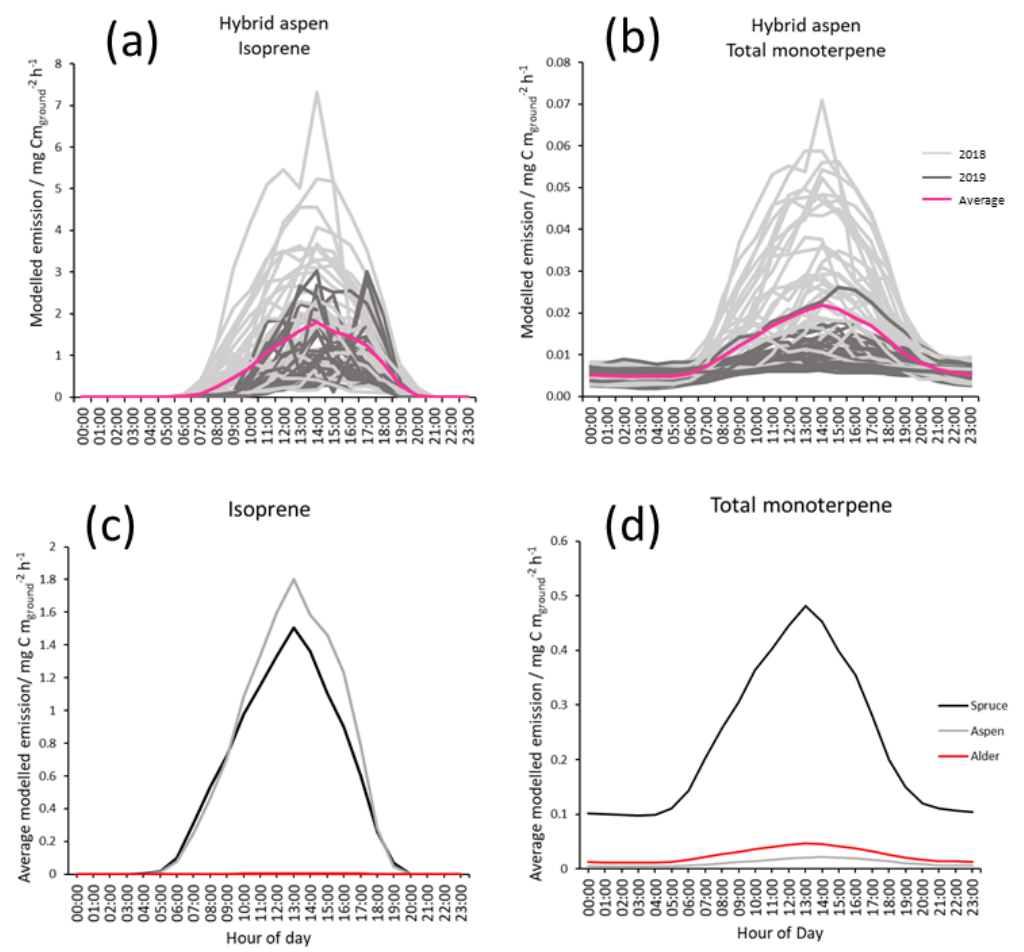
Figure 6. Modelled diurnal canopy emissions for July using MEGAN 2.1 of (a) isoprene from hybrid aspen 2018 (light grey), 2019 (dark grey) and combined mean emission rate (pink); (b) total monoterpene hybrid aspen (light grey), 2019 (dark grey) and combined mean emission rate (pink); (c) mean modelled isoprene for three SRF species, spruce (Black), aspen (grey) and alder (red) for July 2018–2109; and (d) mean modelled total monoterpene for three SRF species, spruce (Black), aspen (grey) and alder (red) for July 2018–2109. Results used measured PAR, temperature and the mean summer branch emission potentials collected during this study (Table